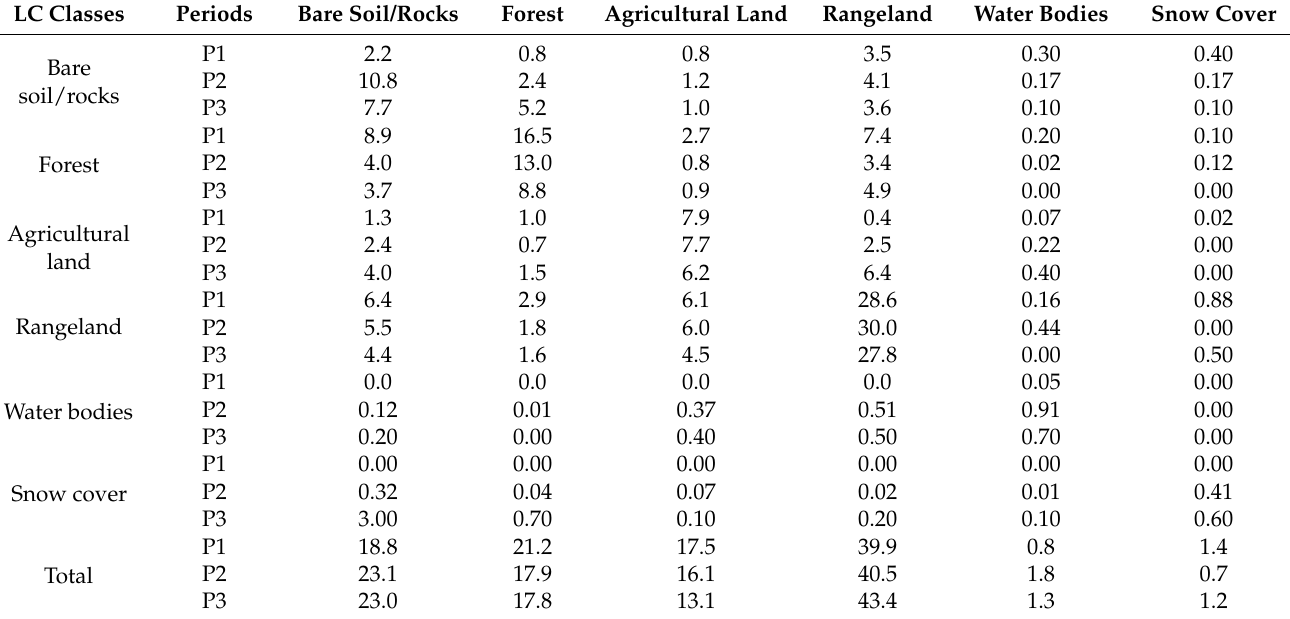
Figure 3. Change detection in land use and land cover classes in all three periods. Table 2. Land use and land cover conversion in all three time periods (percentage out of total area).